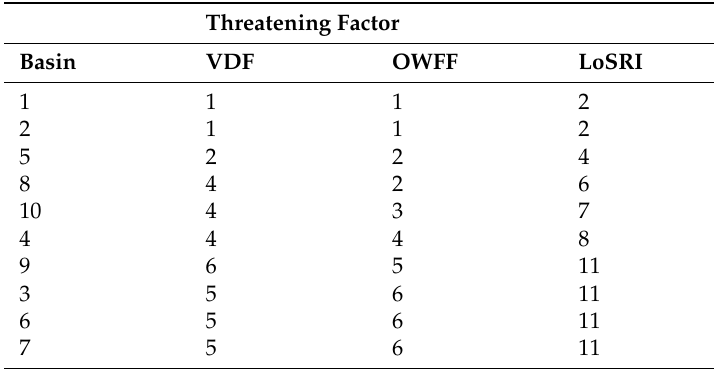
Table 4. Summary of basin threat factors (VDF: Vegetation Density Factor; OWFF: Open Water Fraction Factor; LoSRI: Level of Sedimentation Risk Index).